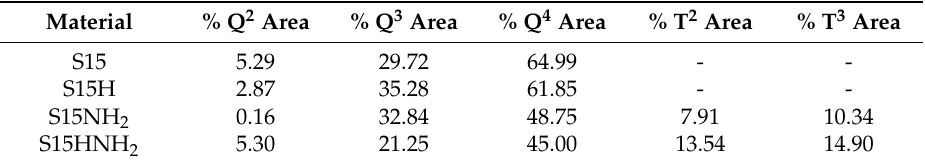
Table 2. Areal percent of signals proceeding from Nuclear Magnetic Resonance (NMR) spectra obtained from the deconvolution of the respective signals of precursor and amine-functionalized